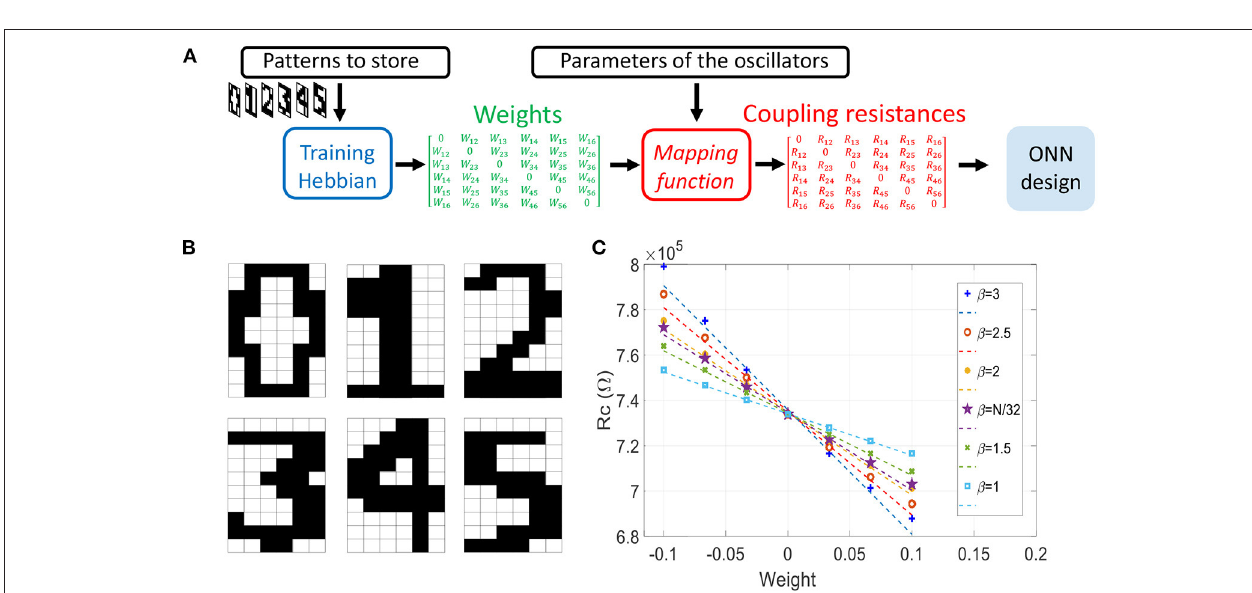
FIGURE 12 | (A) Illustration of the ONN design flow for the associative memory application. Patterns to store can be represented as black and white images from which we compute weights with the Hebbian rule during the training process. Then, we use the mapping function µ N to get the coupling resistances, allowing a systematic ONN design. (B) Stored patterns. (C) Coupling resistances as a function of Hebbian weights, computed with the mapping function µ N for different values of parameter β